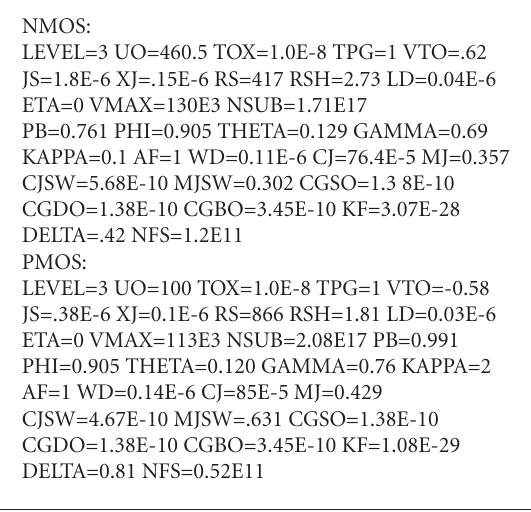
Algorithm 1: Model parameters used for simulation.